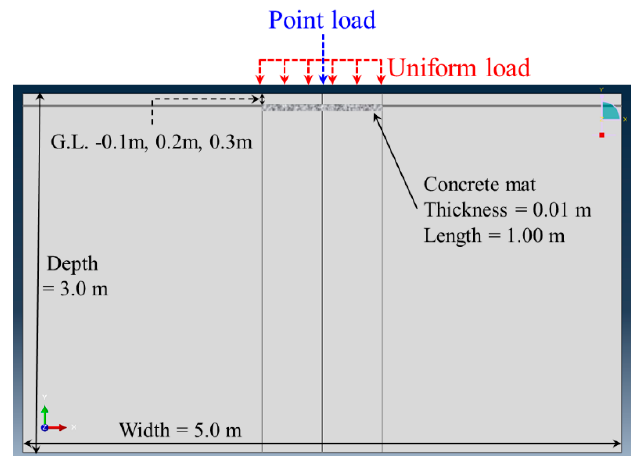
Figure 9. FEA model considering the soil density and the load type .